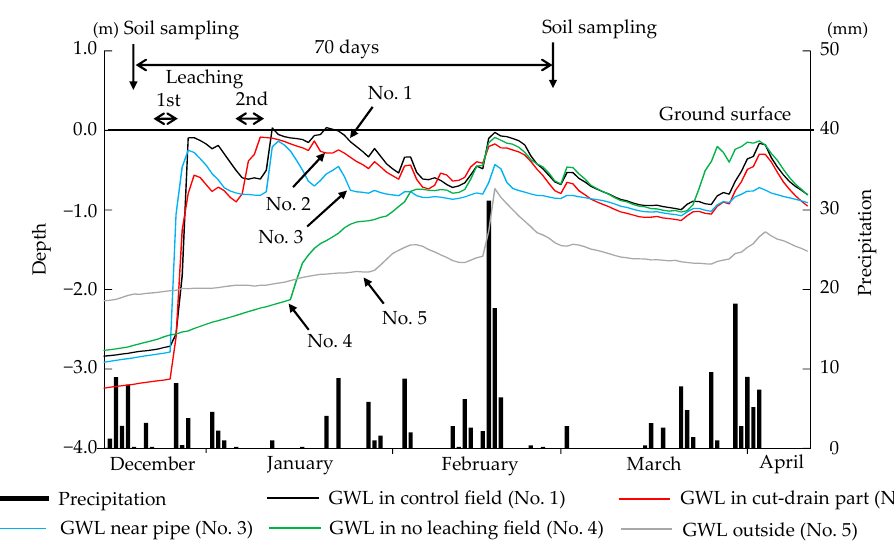
Figure 6. Changes in groundwater level and precipitation. Note: The GWLs show averages for 24 h. The height of ground surface corresponds to that of each observation well point. The lines and bars show the GWL from the ground surface and precipitation, respectively.